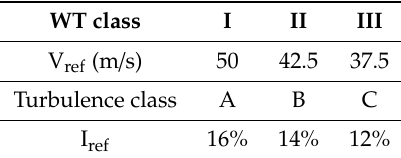
Table 1. Wind related parameters of the wind-turbine (WT) classes.